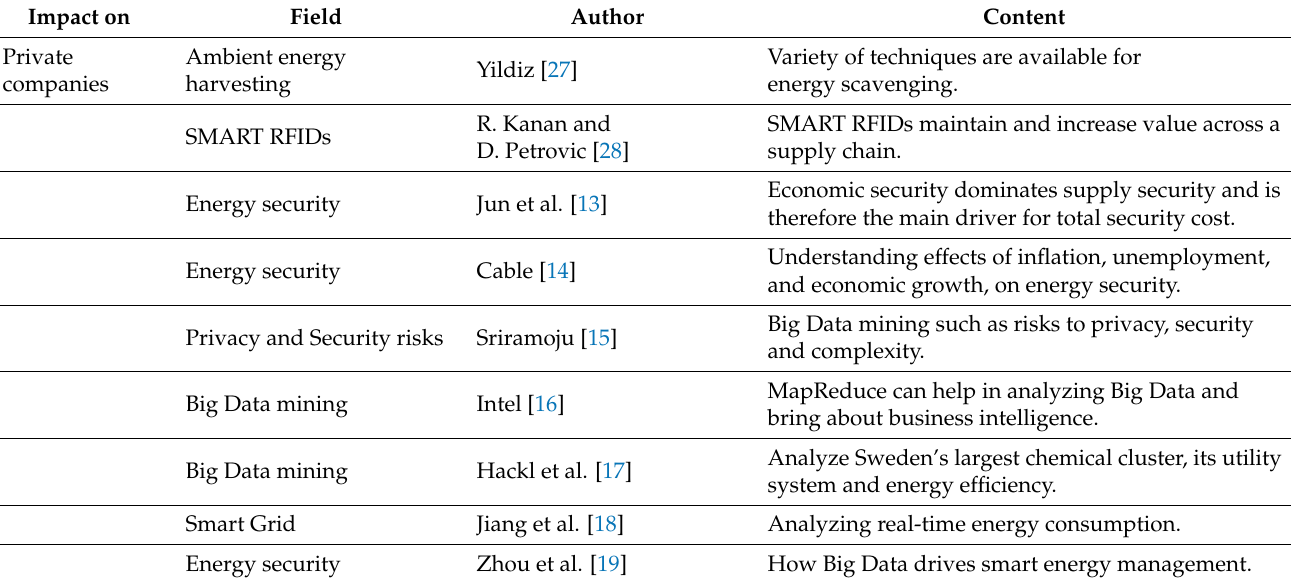
Table A1. Classification and comparison of authors and sources regarding their research